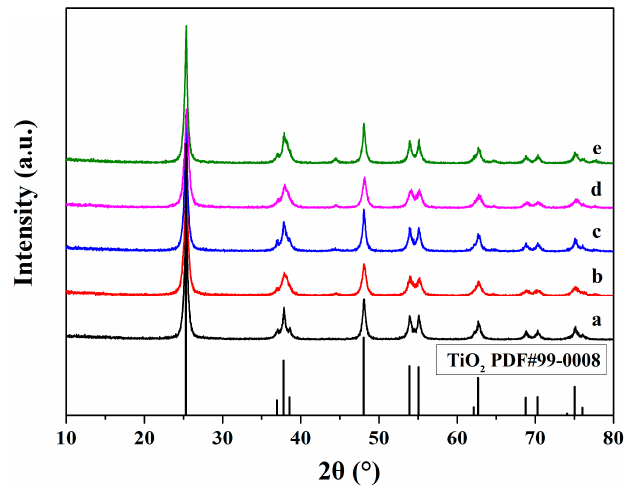
Figure 1. XRD pattern of ( a ) TiO 2 NTs and Au/TiO 2 NTs with different gold contents: ( b ) 0.25 wt.%, ( c ) 0.5 wt.%, ( d ) 0.75 wt.%, and ( e ) 1.0 wt.%.